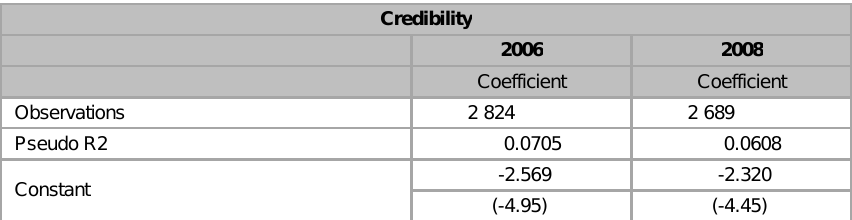
Logistic regression of inflation